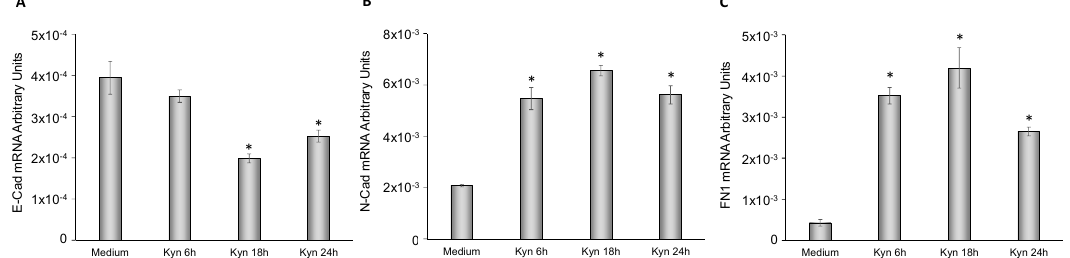
Figure 8. Effect of kynurenine on EMT markers in FTC-133 . FTC-133 cells were incubated for the indicated times with kynurenine (100 µM) and harvested for total RNA extraction and cDNA synthesis. E-cadherin ( A ), N-cadherin ( B ), and fibronectin-1 ( C ) mRNA expression levels were assayed by qPCR. The data are presented as means of arbitrary units. All experiments were repeated three times and the more representative results are depicted. Kyn: kynurenine treated cells. p values were calculated applying the unpaired Student’s t test. *, p < 0.05.